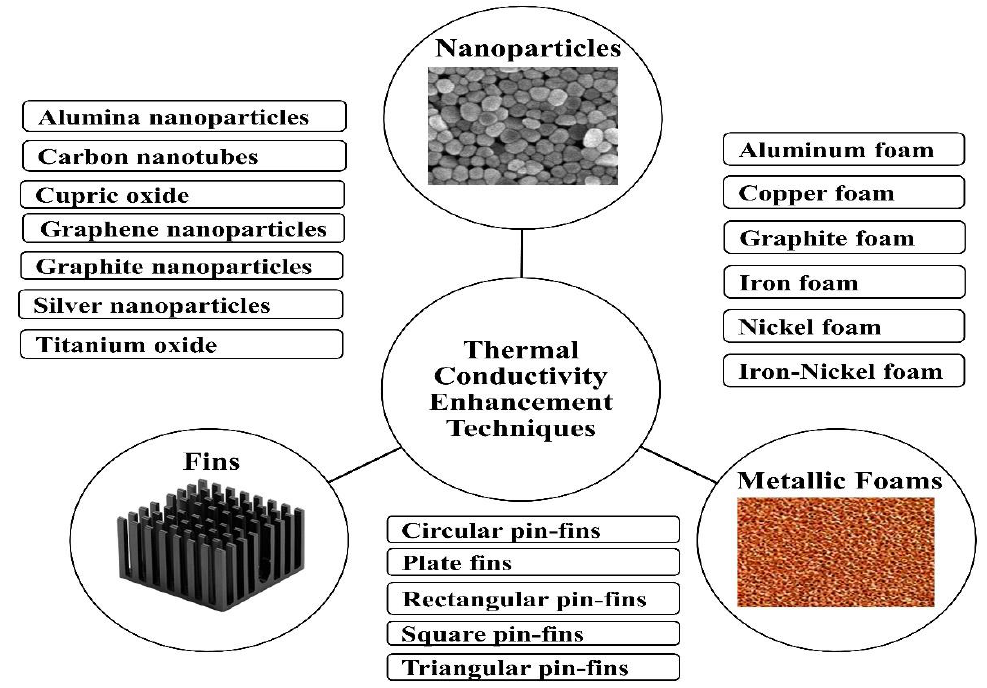
Figure 1. PCMs thermal conductivity enhancement techniques.